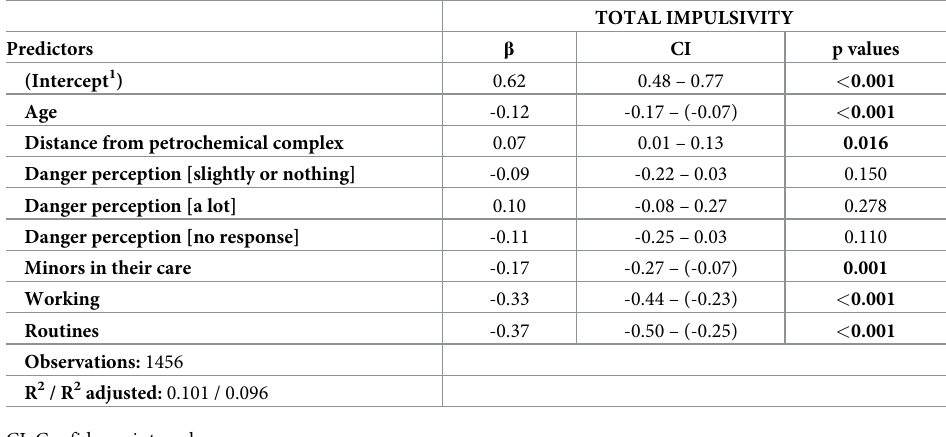
Table 11. Regression analysis relating to total impulsivity in the